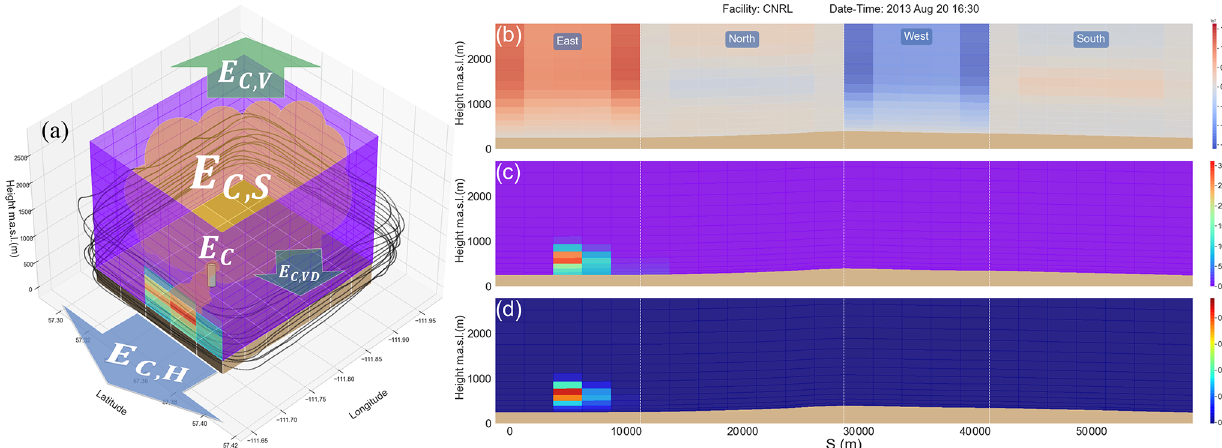
Figure 2. SO 2 mixing ratio screen around CNRL extracted from the GEM-MACH model output at the start of case 4 on 20 August 2013 at 16:30UT (10:30LT). (a) Mixing ratio data (2D) on the lateral walls of the flux box, along with the flight tracks plotted as dark dots. The additional graphics (arrows and plumes) on (a) represent processes contributing to change in tracer mass within the box volume: source emission rate ( E C ), horizontal flux ( E C , H ), vertical flux ( E C , V ), surface deposition ( E C , VD ) and storage rate ( E C , S ). The extracted fields around the box are unwrapped onto a 2D screen comprised of box lateral walls (east, north, west and south) and shown in (b) the normal air flux (positive outwards), (c) SO 2 mixing ratio and (d) SO 2 mass flux through the screen. Note that the net flux on box corners is the vector sum of the fluxes in west–east ( U ) and south–north ( V )